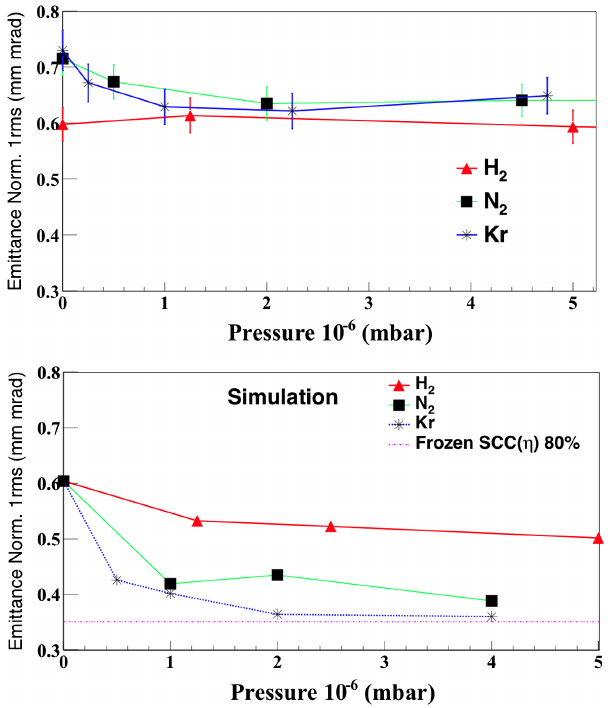
FIG. 14. Emittance versus injected gas pressure for measure- ments (top) and simulations (bottom), for different injected gas types.